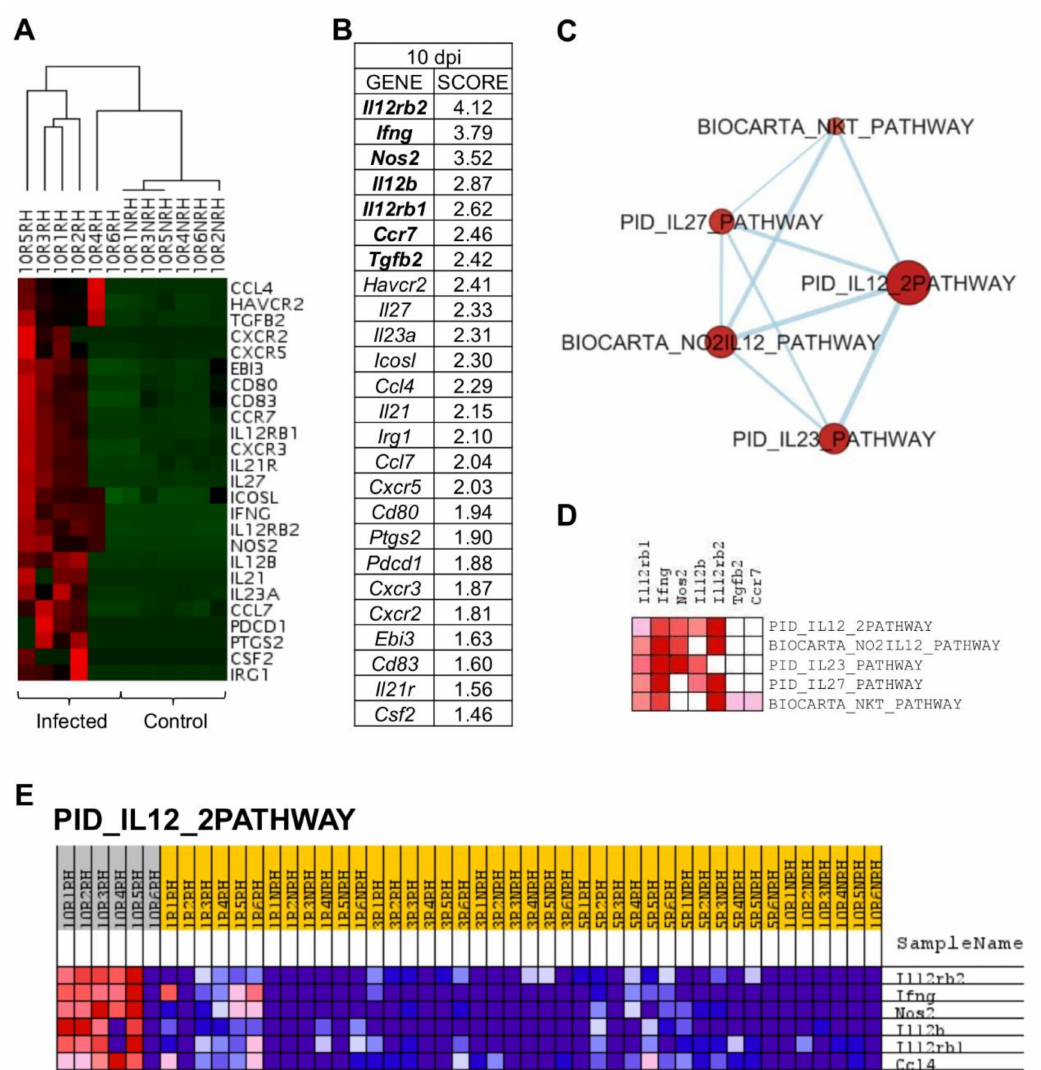
Figure 6. L. infantum infection induces Th1 responses through interleukin-12 signaling at 10 days post infection: ( A ) Unsupervised hierarchal clustering of 10 days p.i. and control mice including genes correlated with Principal Compo- nent 3 (PC3) was applied and based on Euclidean distance and pairwise average-linkage. Differential expression of selected genes in 10 days p.i.-mice (left side) and control mice (right side) is shown. Each mouse is identified with a respective code. Genes downregulated during infection are shown in green and upregulated genes are in red; ( B ) Ranked gene list generated in GSEA (using PC3-correlated genes to compare gene expression in 10 days p.i.-mice vs. all other mice). Genes indicated in bold were involved in the core enrichment; ( C ) Enrichment Map with PC3-correlated genes shows the relevance of IL-12 signaling pathway at 10 days p.i. Parameters to filter these nodes/gene sets applied in Cytoscape: p -value < 0.05 and FDR < 0.25. Intensity of node color fill represents FDR value (more intense red color indicates lower FDR); node size corresponds to the NES value. Thicker connection lines represent higher similarity coefficient between nodes; ( D ) Core enrichment of PC3-gene sets. The leading edge analysis was performed in GSEA with the gene sets enriched (with p -value < 0.05 and FDR < 0.25). The heatmap shows the clustered genes in the leading edge subsets. Score values in the ranked gene list generated in GSEA are represented as colors, where the range of color (red, pink) shows the range of score values (high, moderate); ( E ) PID_IL12_2PATHWAY heatmap. This gene set was upregulated in 10 days p.i.-mice (PC3 dataset). Upregulation of these genes in 10 days p.i.-mice (left side) and the rest of mice is shown. Each mouse is identified with a respective code. Genes are ordered by tTest ratio according to their differential expression. Normalized relative quantities (NRQ) are represented as colors, where the range of colors (red, pink, light blue, dark blue) shows the range of expression values (high, moderate, low,